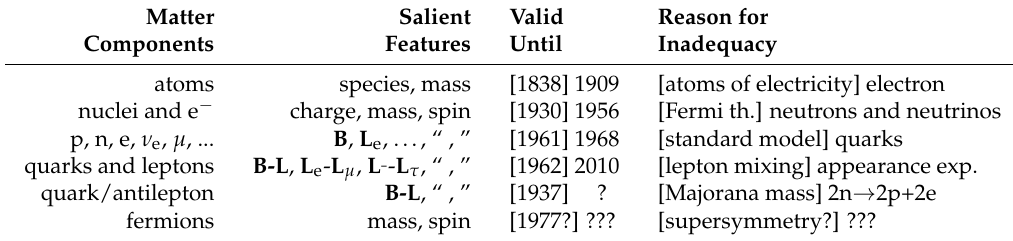
Table 3. Table of elementary components of matter according to different models, successive in time. Left columns: brief description. Right ones: shortcomings of the given model. Dates and